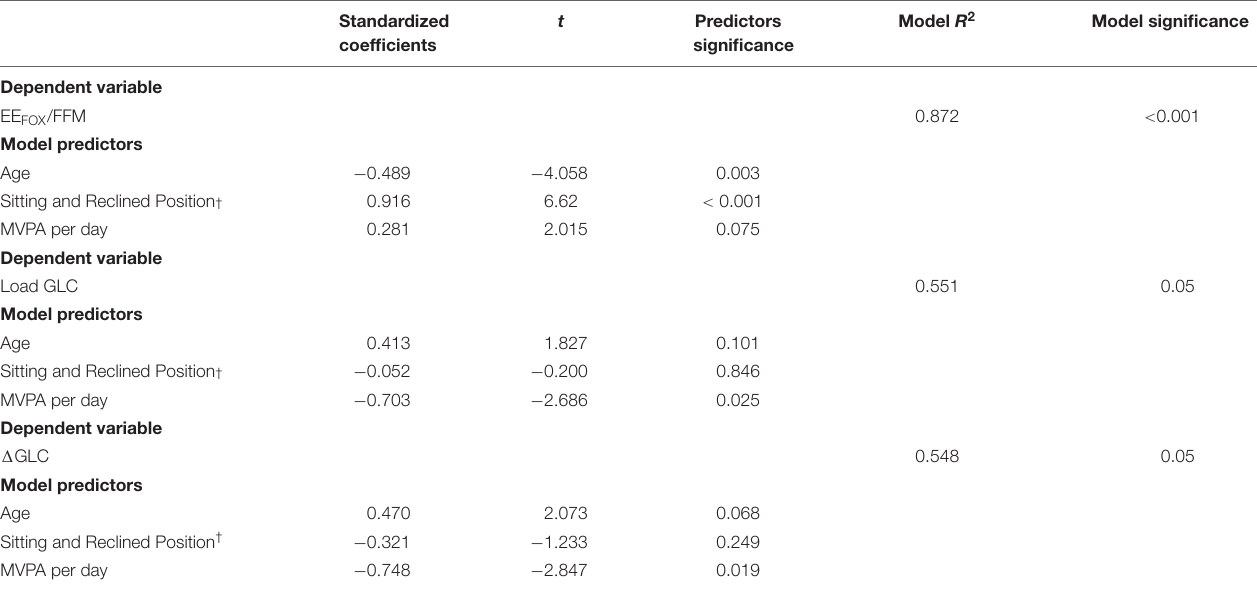
TABLE 5 | Correlation coefficients obtained using a multiple regression model (controlling for the confounding effect of age) to test the significance of SB and PA parameters as predictors of fat contribution to energy metabolism (EE FOX /FFM) and of peak and changes of capillary blood glucose levels in response to oral meal (Load GLC and (cid:49) GLC), in the subjects of the study ( N =